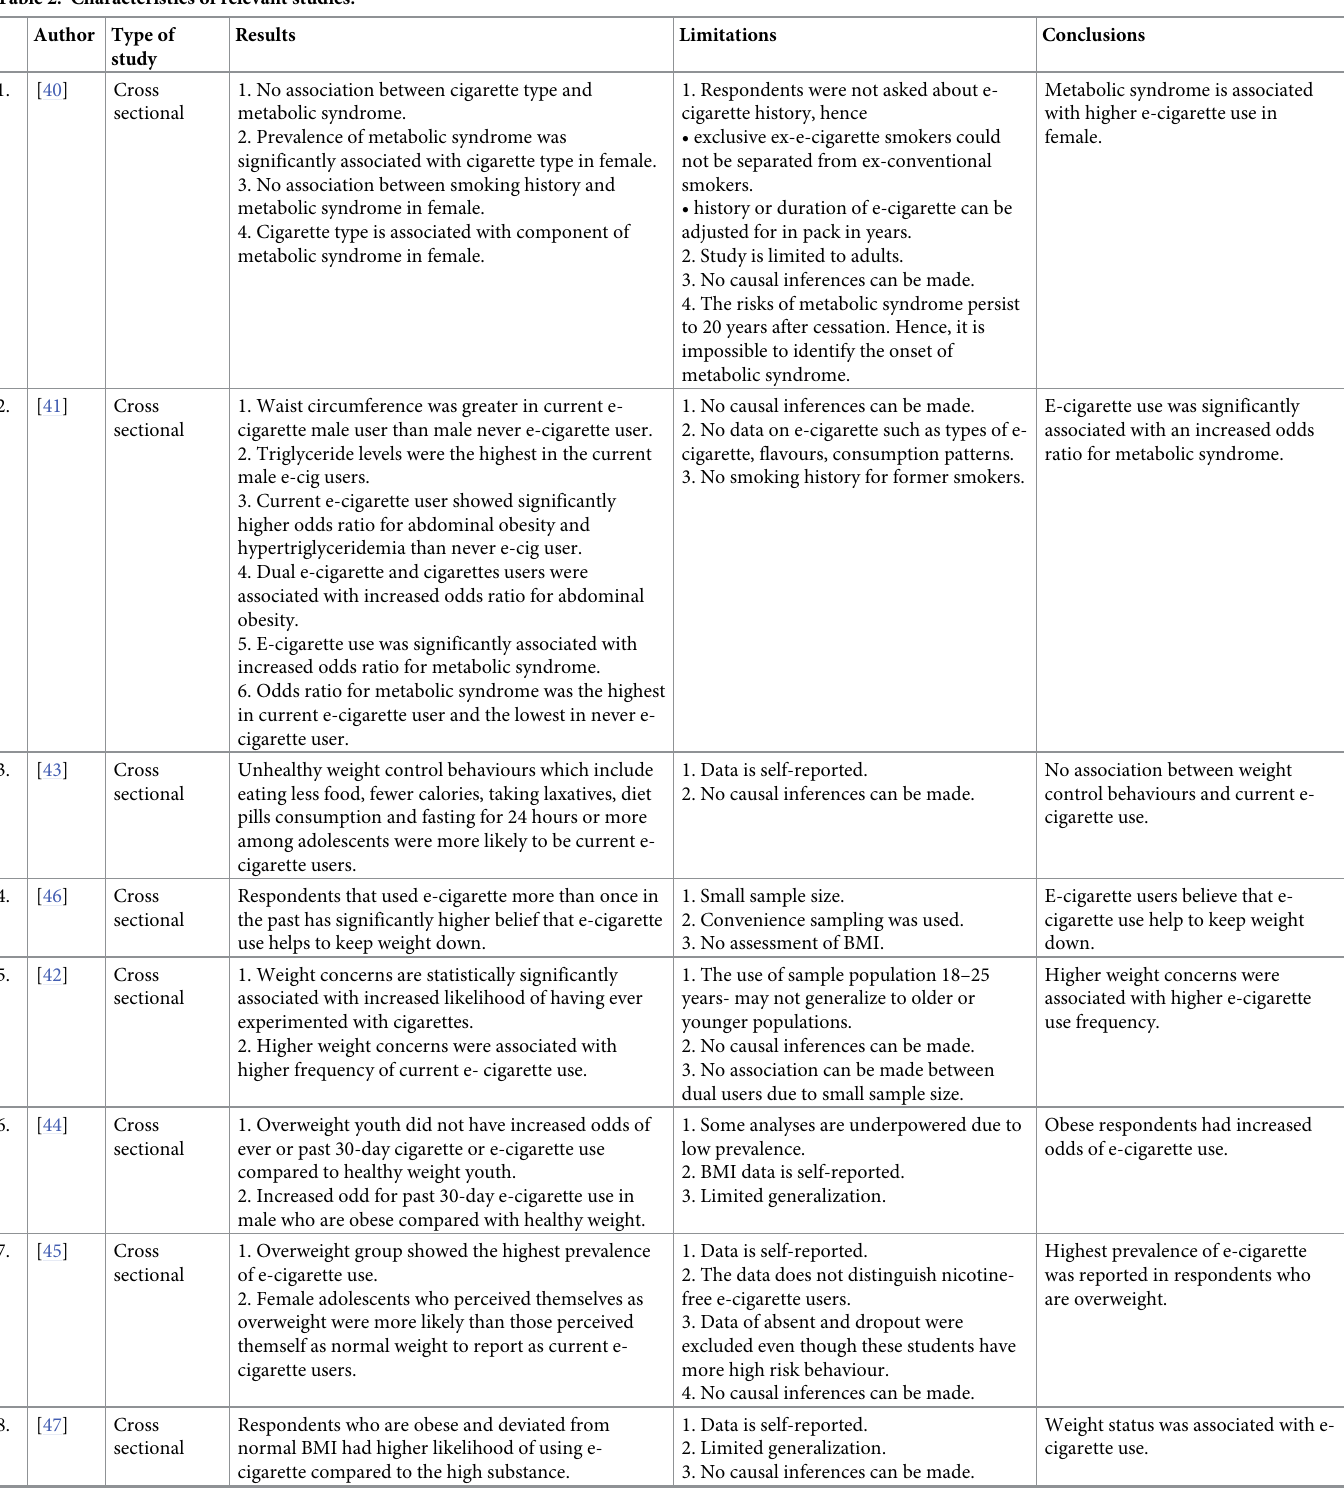
Table 2. Characteristics of relevant